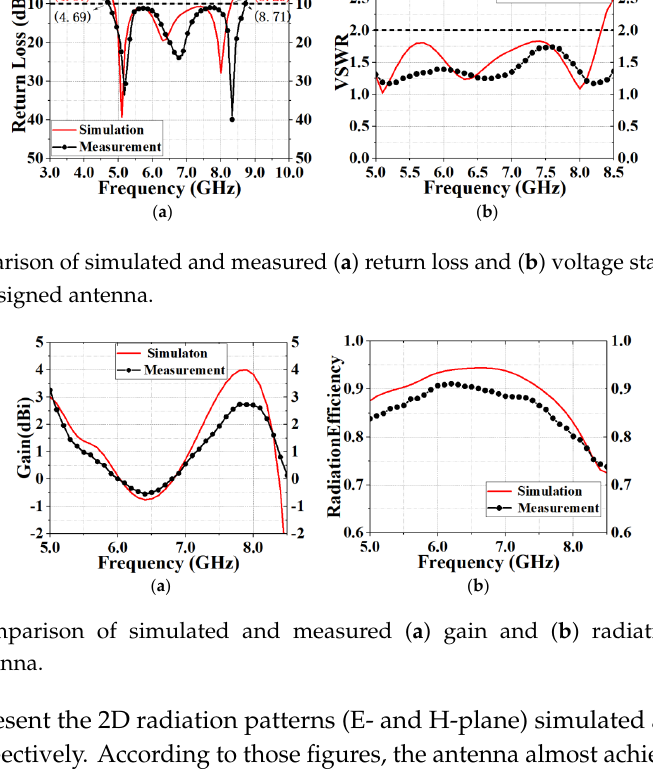
Figure 12. Comparison of simulated and measured ( a ) gain and ( b ) radiation efficiency of the designed antenna.